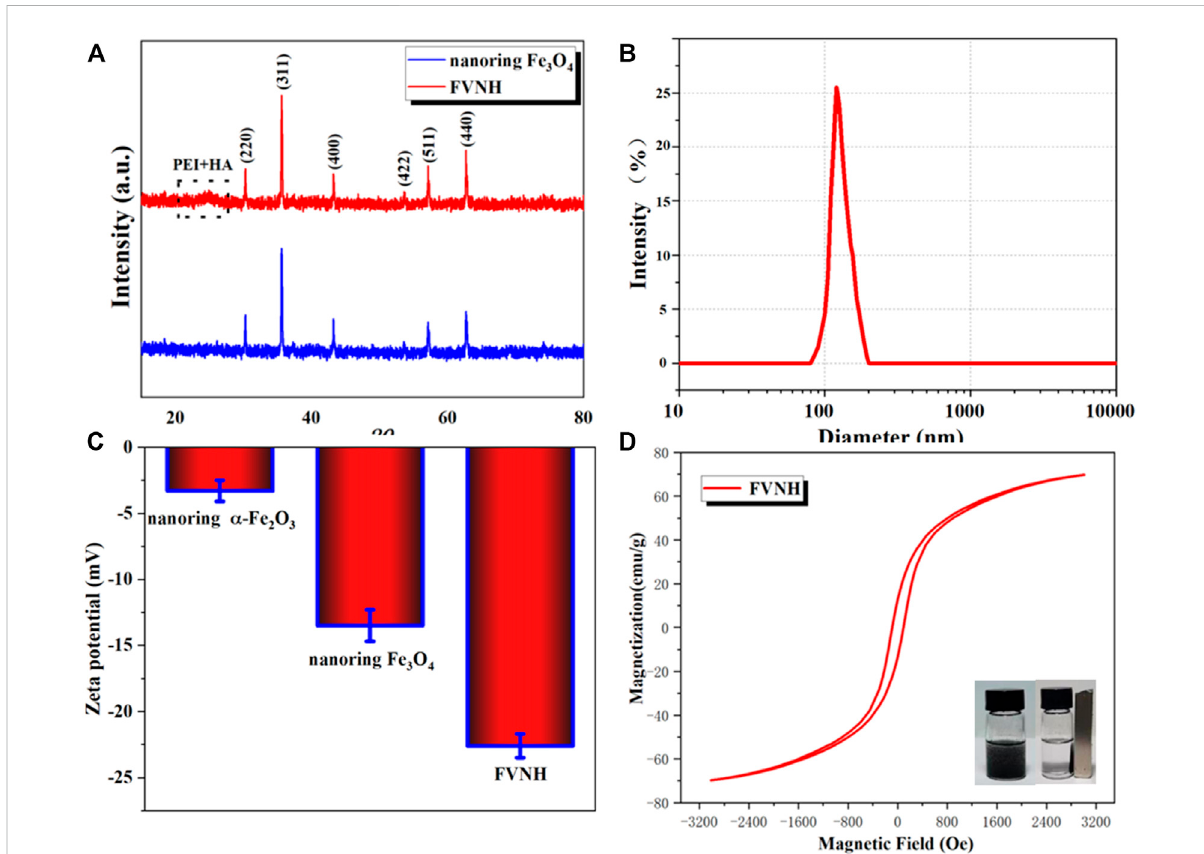
FIGURE 2 (A) X-ray diffraction patterns of naked nanoring Fe 3 O 4 and FVNH. (B) The hydrodynamic diameter distribution of synthesized FVNH in water measuredbyDLS. (C) Zetapotentialsofthenanoparticlesfordifferentsyntheticsteps. (D) ThehysteresiscurvesofFerrimagneticFVNHnanoparticles and photographs of the FVNH solution in PBS with and without a magnet